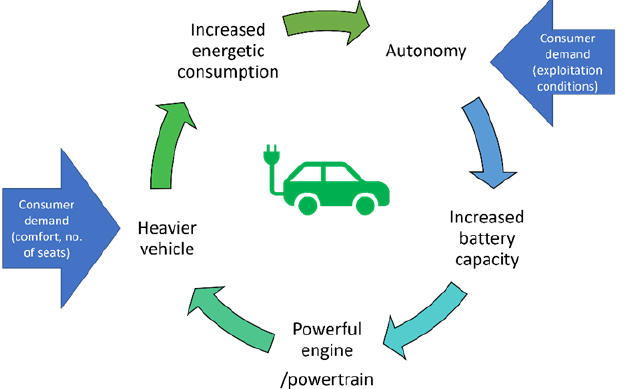
Figure 1. Continued dependence between the main performance parameters of electric vehicles and interference of consumer